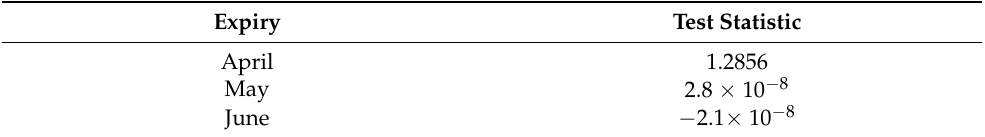
Table 4. Likelihood ratio test